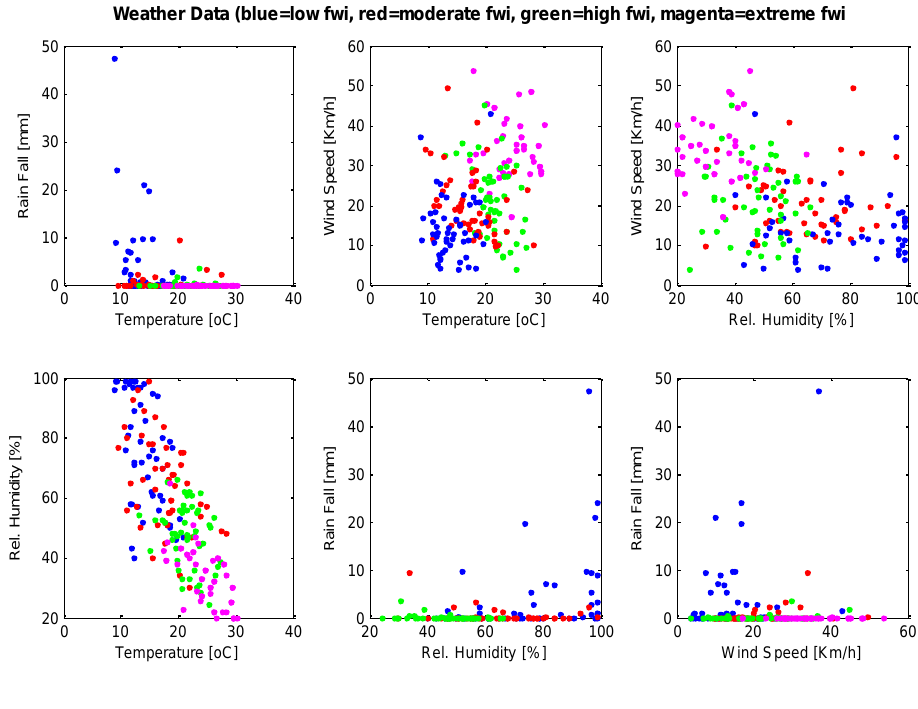
Figure 2. 2D classification of the weather database.